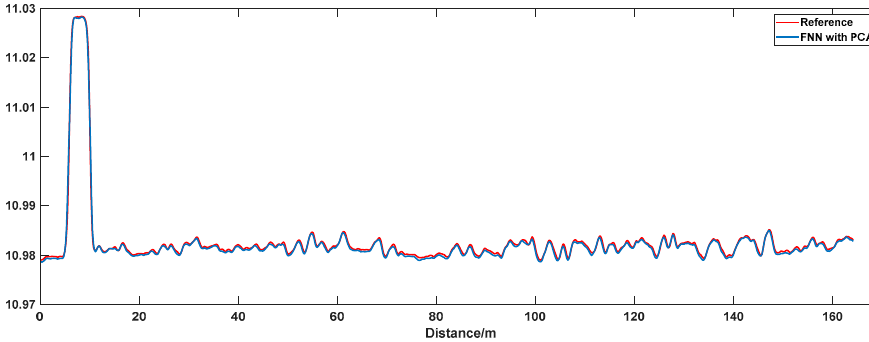
Figure 12. Errors between FNN with PCA and LCF along the fiber under test are shown, in the form of the black line. The blue line represents the BFS estimated by FNN with PCA along the fi- ber. 5. Conclusions An accurate and ultra-fast method for estimating BFS from BGS is was and system- atically compared with FNN with PCA and FNN without PCA. By comparison, our ap-